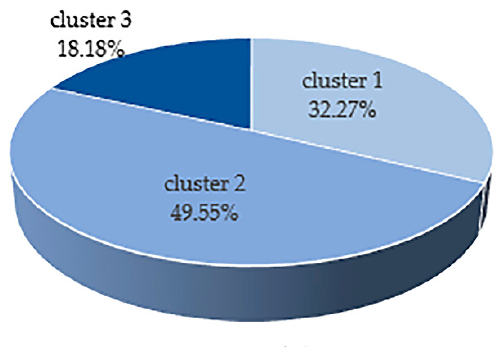
Figure 3. Size of Figure 3. Size of clusters.